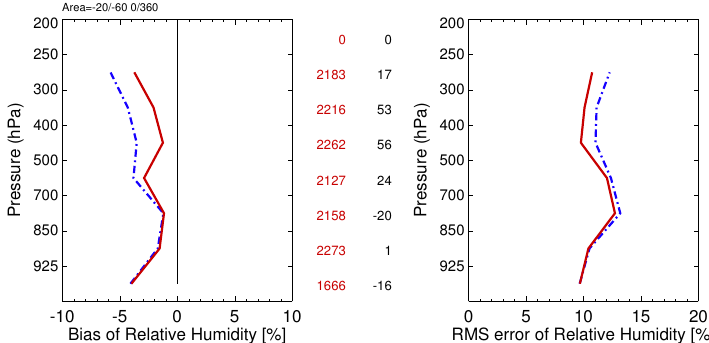
Fig. 3. The mean departure (left) and RMS difference (right) of radiosonde humidity observations to 3-h forecasts for the reference run (dash-dotted blue line) and the GPSRO experiment (continuous red line) in the Southern Hemisphere (60 ◦ S–20 ◦ S). The central columns refer to the number of used observations, cf. caption of Fig. 2.